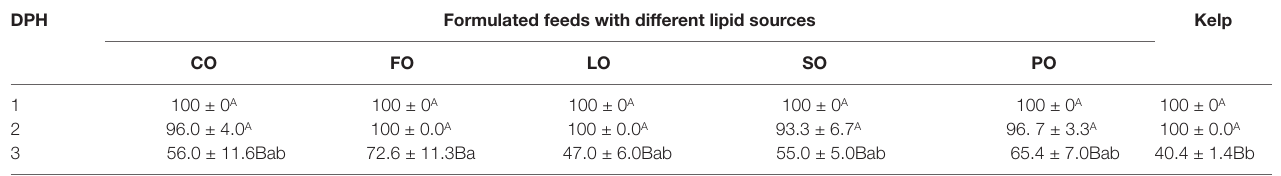
TABLE 6 | Effects of different lipid sources on the prismatic larvae survival of sea urchin ( Strongylocentrotus intermedius) at different day post hatching (DPH) (mean ± SEM, n=3) 1 .